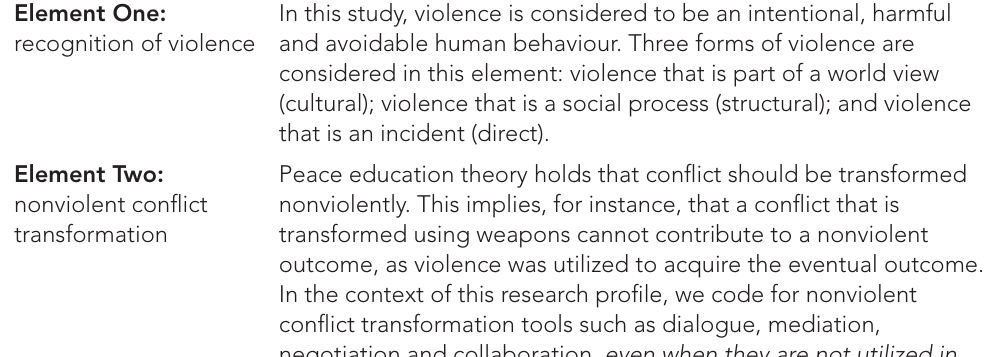
Table 1: Three elements of peace education Element